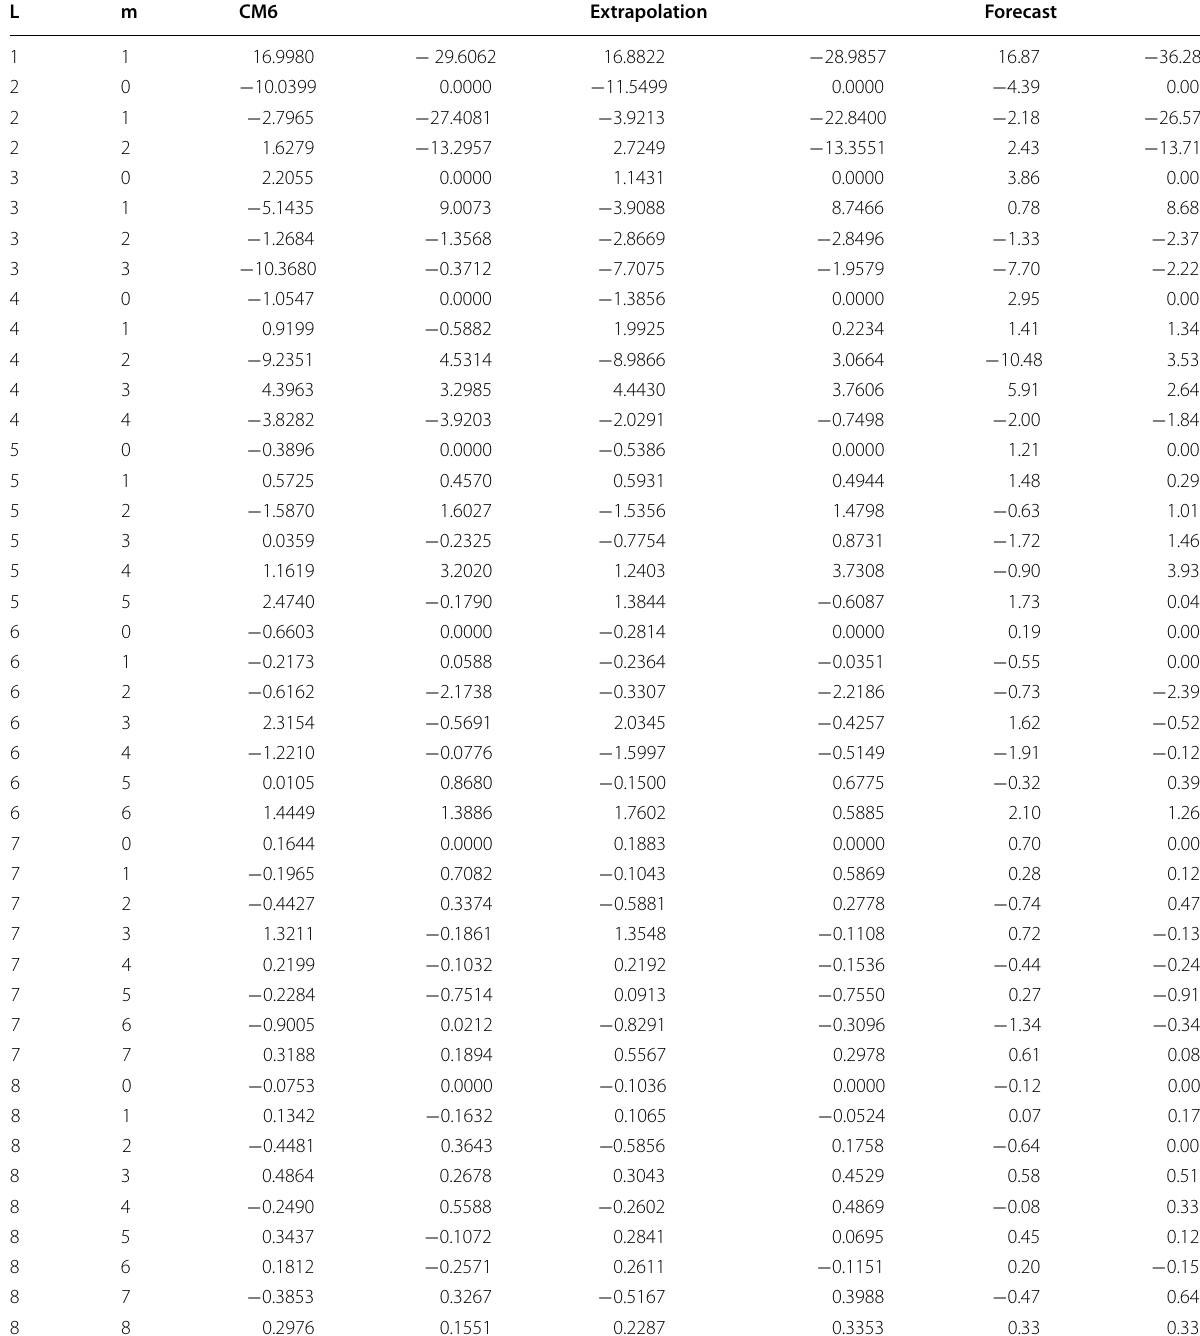
Table 2 SV for 2010-2015 validation experiments from CM6, the GEMS EnKF, and extrapolations of CM6 from 2009-2010 L m CM6 Extrapolation